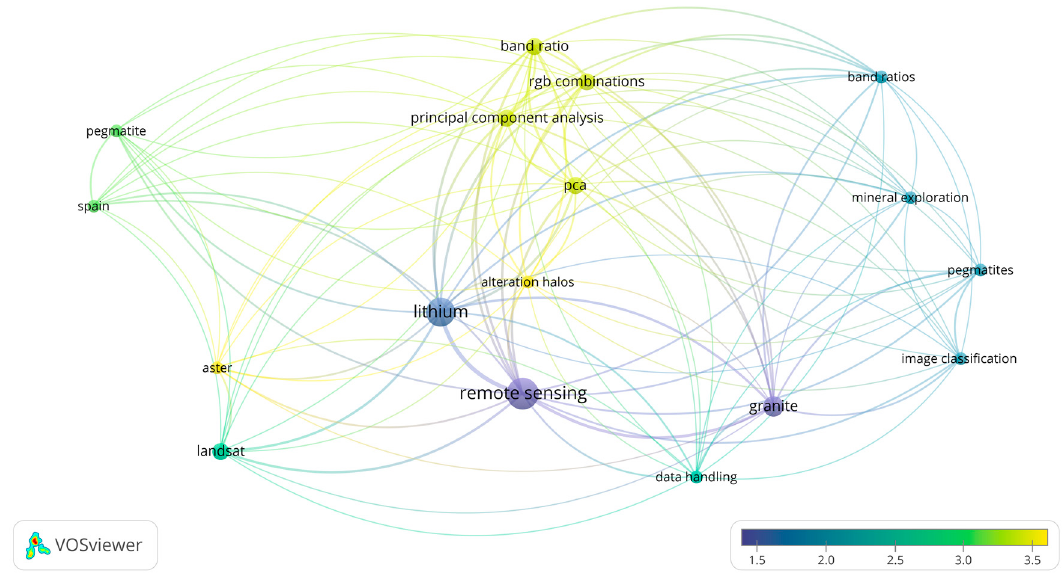
Figure 2. Co-occurrence of author and index keywords. Each circle represents a different keyword, being the size proportional to the respective number of occurrences. The color represents the average citation associated with each keyword, while the lines represent the link strength between different keywords. The minimum number of occurrences of a keyword considered was two, with 17 keywords having met the criteria.